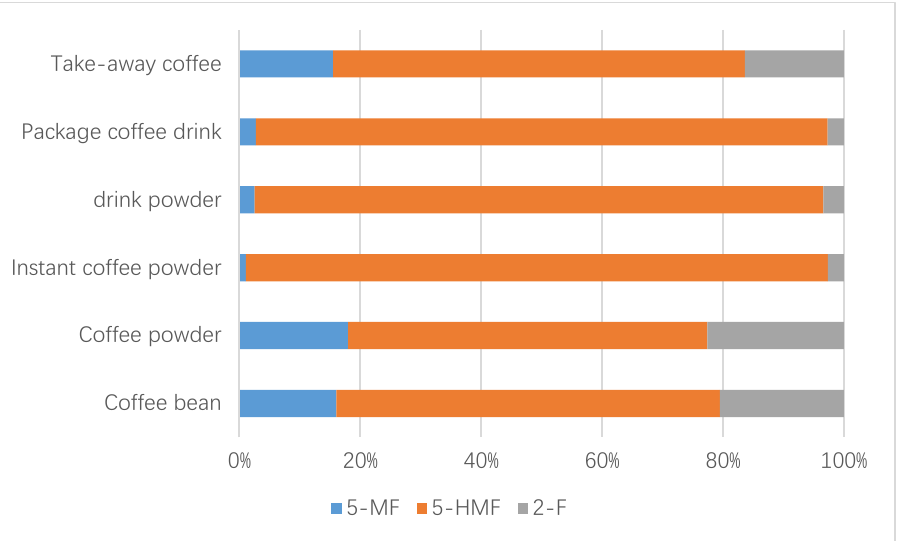
Figure 3. Contributions (%) of 5-MF, 5-HMF, and 2-F to the total furfural and its derivatives’ concentrations for each coffee product.